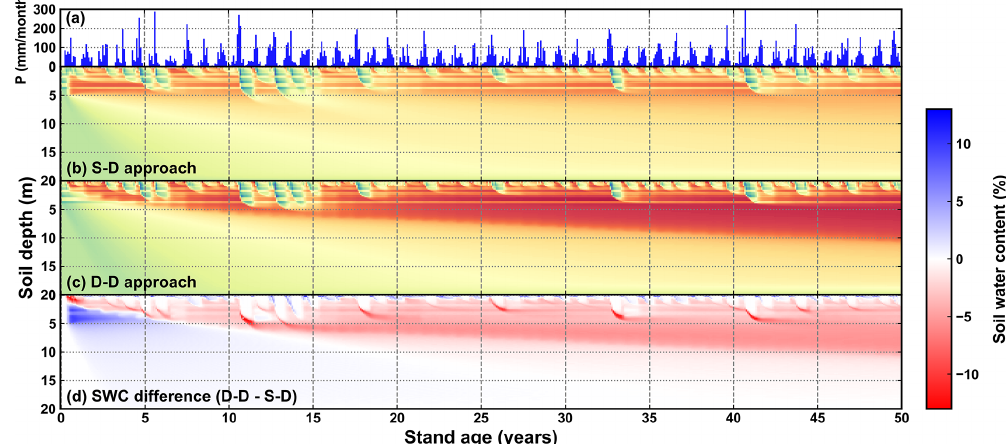
Figure 9. Time series of (a) monthly precipitation (mm per month), (b) soil water content (SWC) along the 20m soil profile simulated by the static rooting depth (S–D) approach, (c) soil water content along the 20m soil profile simulated by the dynamic rooting depth (D–D) approach, and (d) the difference in the SWC between the S–D and D–D approaches. The dashed black horizontal line in panel (b) and the curve in panel (c) indicate the rooting depth.